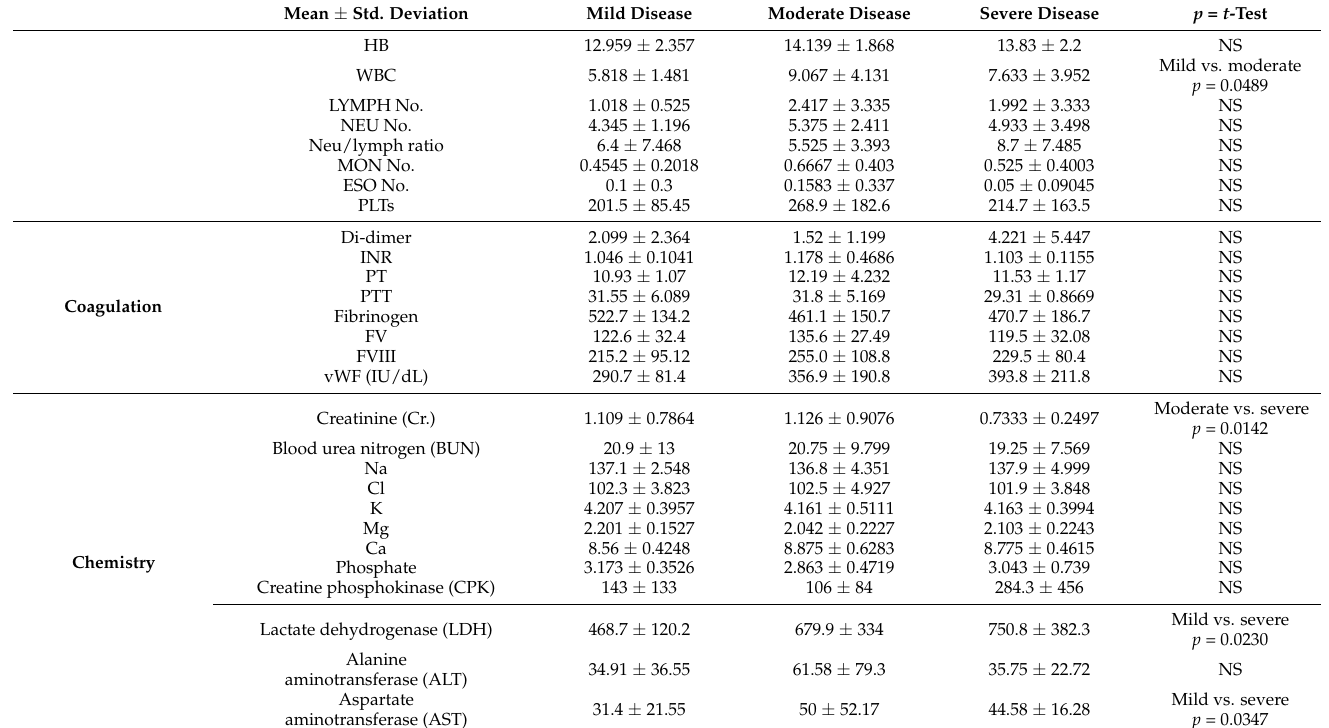
Figure 1. Procoagulant, anticoagulant, and fibrinolytic profiles of COVID-19 patients compared to normal values. ( a ) Normal D-dimer < 0.5 mg/L; ( b ) normal percentage range of protein; C: 70–150%; ( c ) normal range of free protein S: 65–160%; ( d ) normal range of plasma fibrinogen 145–348 mg/dL; ( e ) normal percentage range of alpha2-anti-plasmin (AP) 80–140%. * p <0.05, ** p <0.01, *** p <0.001. Table 2. Patients’ laboratory test